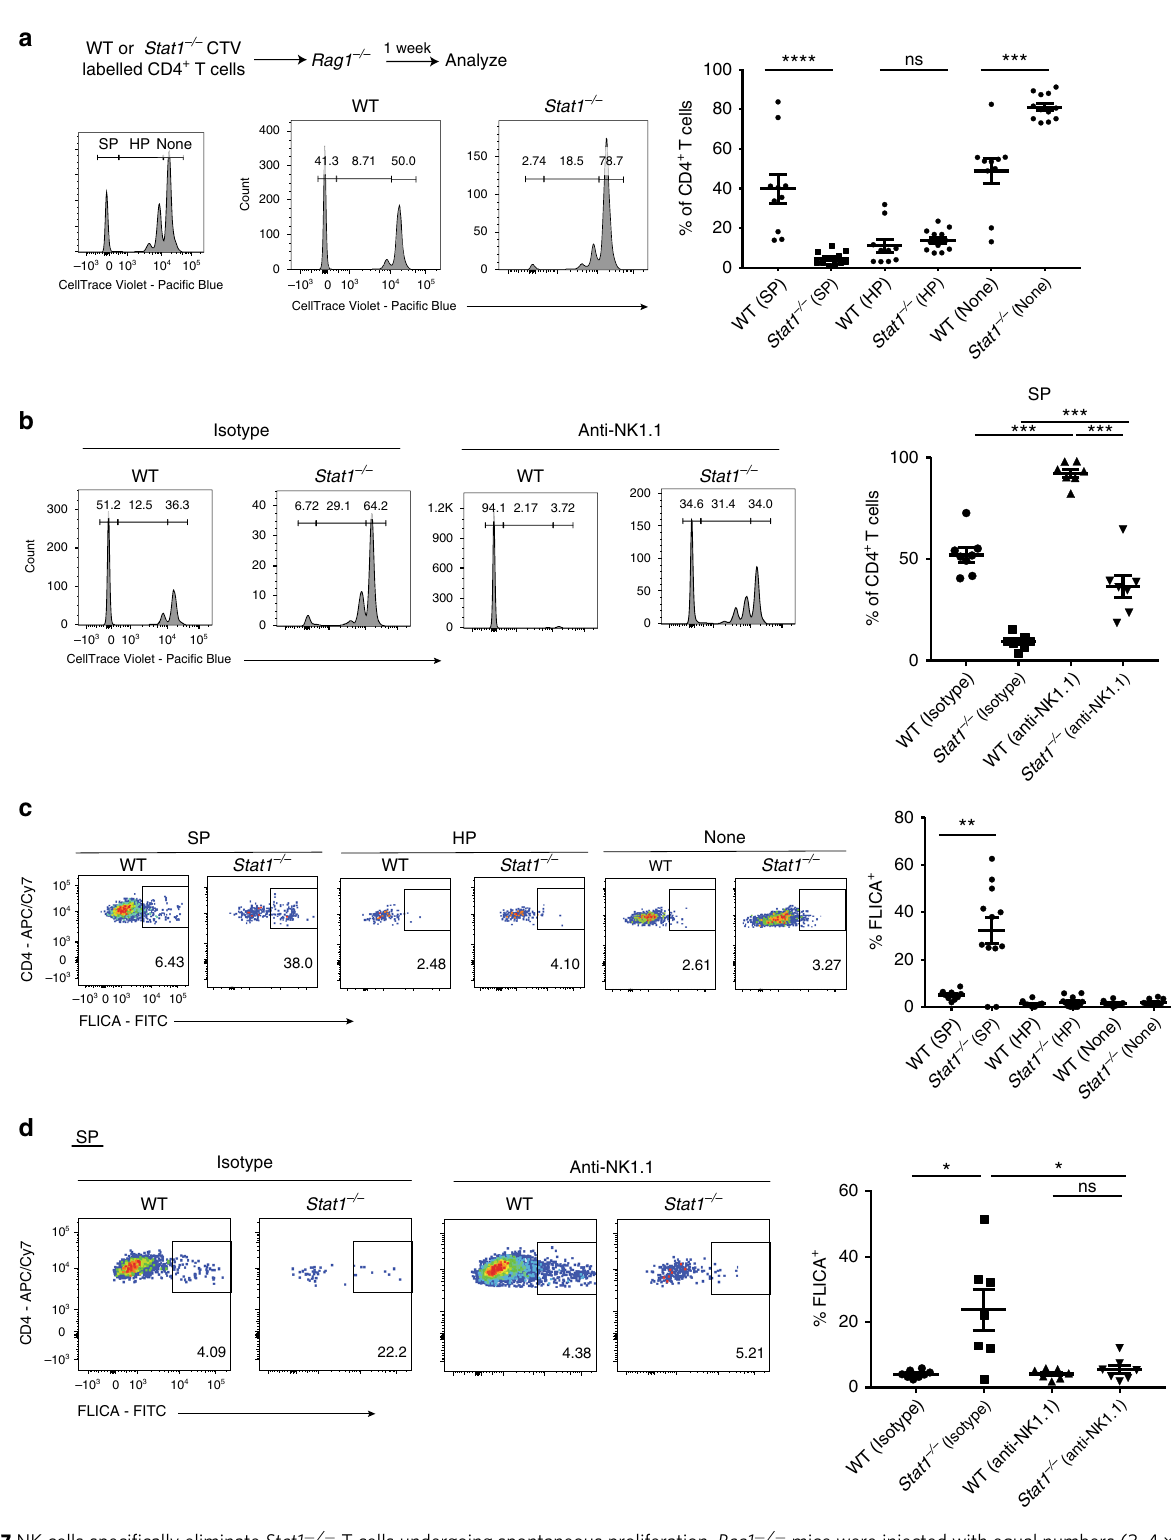
Fig. 7 NK cells speci fi cally eliminate Stat1 − / − T cells undergoing spontaneous proliferation. Rag1 − / − mice were injected with equal numbers (3 – 4 × 10 6 ) of WT or Stat1 − / − CTV labeled unfractionated CD4 + T cells and analyzed after 1 week. a Schematic of experiment, as well as representative fl ow cytometry plots of T cells in the spleen + lymph nodes (gated on live CD45 + CD3 ε + CD4 + cells, Supplementary Fig. 4d) followed by their mean frequencies ± SEM. b , d Similar to a , but with 400 μ g anti-NK1.1 antibody or Isotype Control injected 1 day prior to T-cell transfer. b CTV pro fi les of the T cells are shown as well as the mean frequencies ± SEM of the SP population. c Representative images of FLICA staining from the T cell SP, HP and non-proliferating populations in a , as well as their mean frequencies ± SEM. d FLICA staining in the SP population from b shown with mean frequencies ± SEM shown. Pooled from three to four independent experiments, with each point representing an individual mouse. * p < 0.05, ** p < 0.01, *** p < 0.001, *** p < 0.0001 by